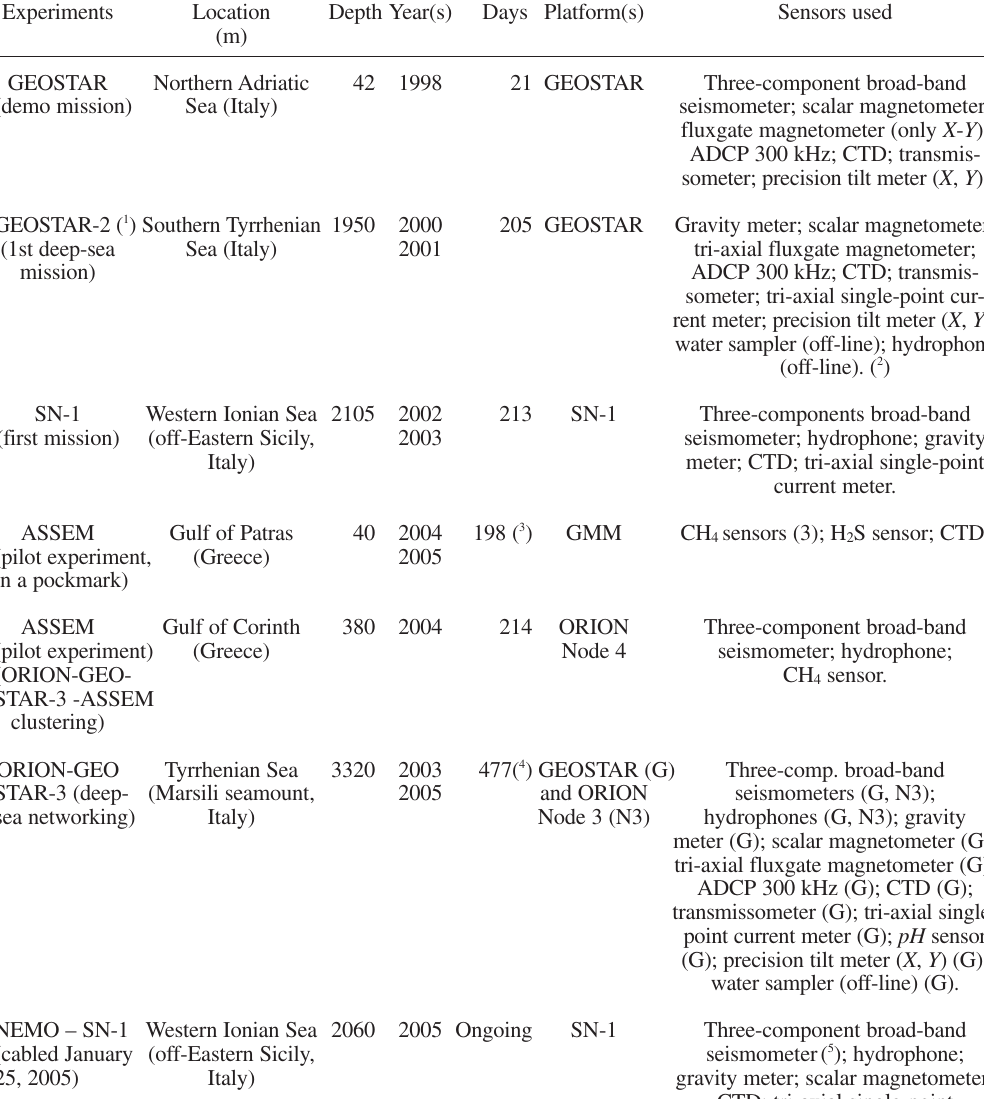
Table VI. List of the seafloor experiments performed with GEOSTAR-class platforms and the sensors used (see fig. 10 for the